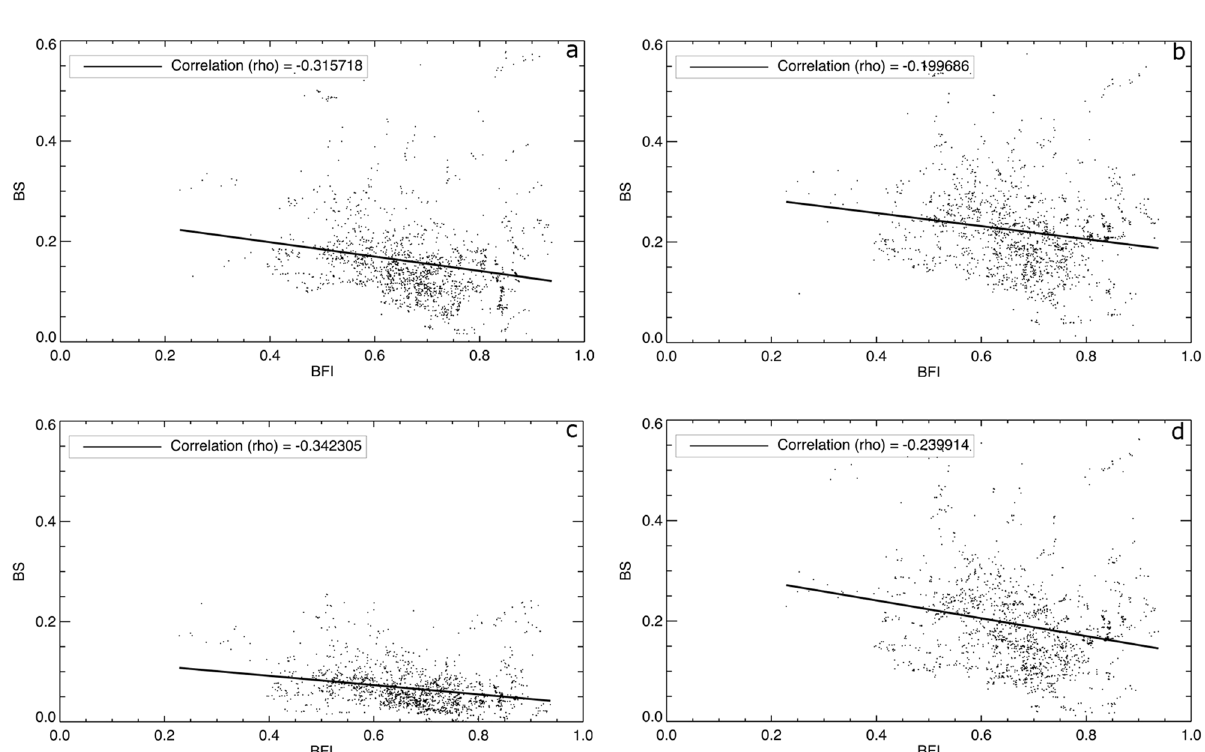
Figure 3. Correlation between BFI and BS for southern European river grid cells: ( a ) for SSI-1 LT = 1, ( b ) for SSI-1 LT = 3, ( c ) for SSI-3 LT = 1, and ( d ) for SSI-3 LT = 3. See Supplementary Table 2 for average BFI and BS values in each European subregion and Europe as a